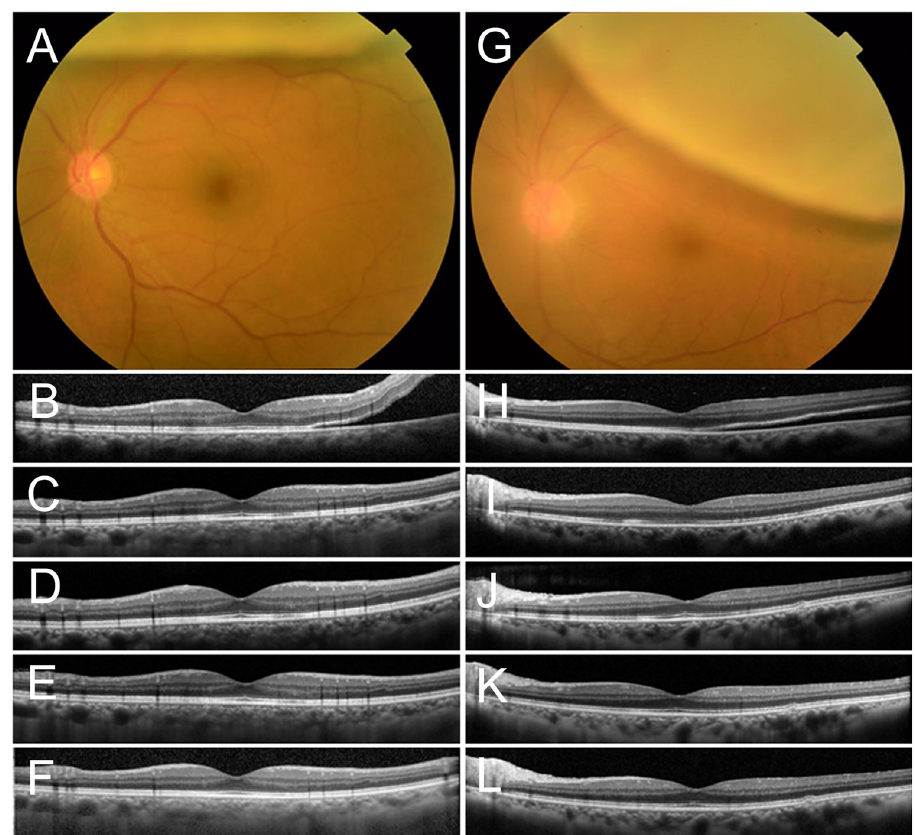
Fig 2. Time course of OCT findings in representative patients whose RRD were present within the vascular arcade but did not involve the fovea. Left panel: A, the preoperative fundus Images of the left eye of a 62-year-old man. The subfoveal OCT findings were normal during the follow-up period (B: Pre, C: 1 months, D: 3 months, E: 6 months, F: 12 months after the surgery, respectively). M-score was normal during the follow-up period. Right Panel: G, the preoperative fundus Images of the left eye of a 62-year-old man. The subfoveal OCT findings were normal during the follow-up period (H: Pre, I: 1 months, J: 3 months, K: 6 months, L: 12 months after the surgery, respectively). Preoperative M-score was normal, but vertical and horizontal M-score were 0.4 and 0.3 after 12months surgery,